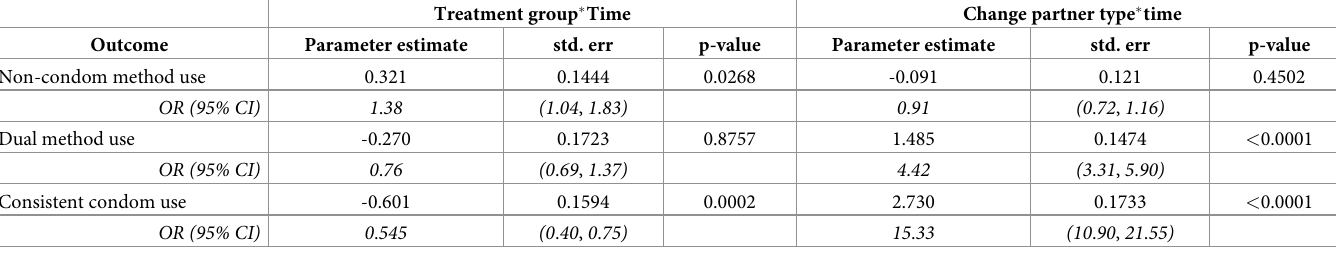
Table 3. Parameter estimates and exponentiated odds ratios for treatment � time and change in partner type � time effects on primary outcomes 1 , imputed data.